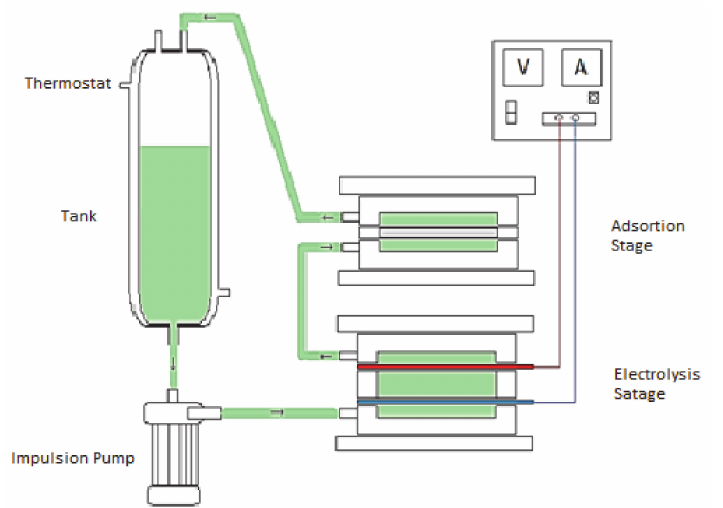
Figure 6. Scheme of the two electroadsorption